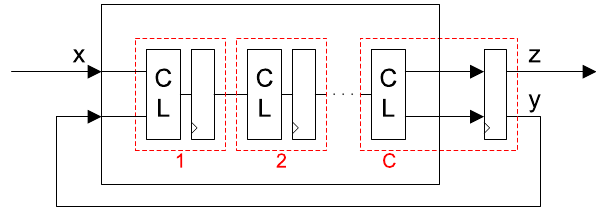
Figure 10. C -slowed